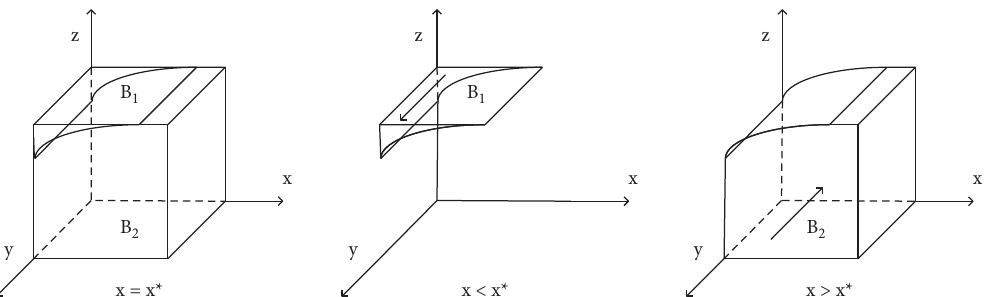
Figure 3: Phase diagram of the public’s strategy evolution.